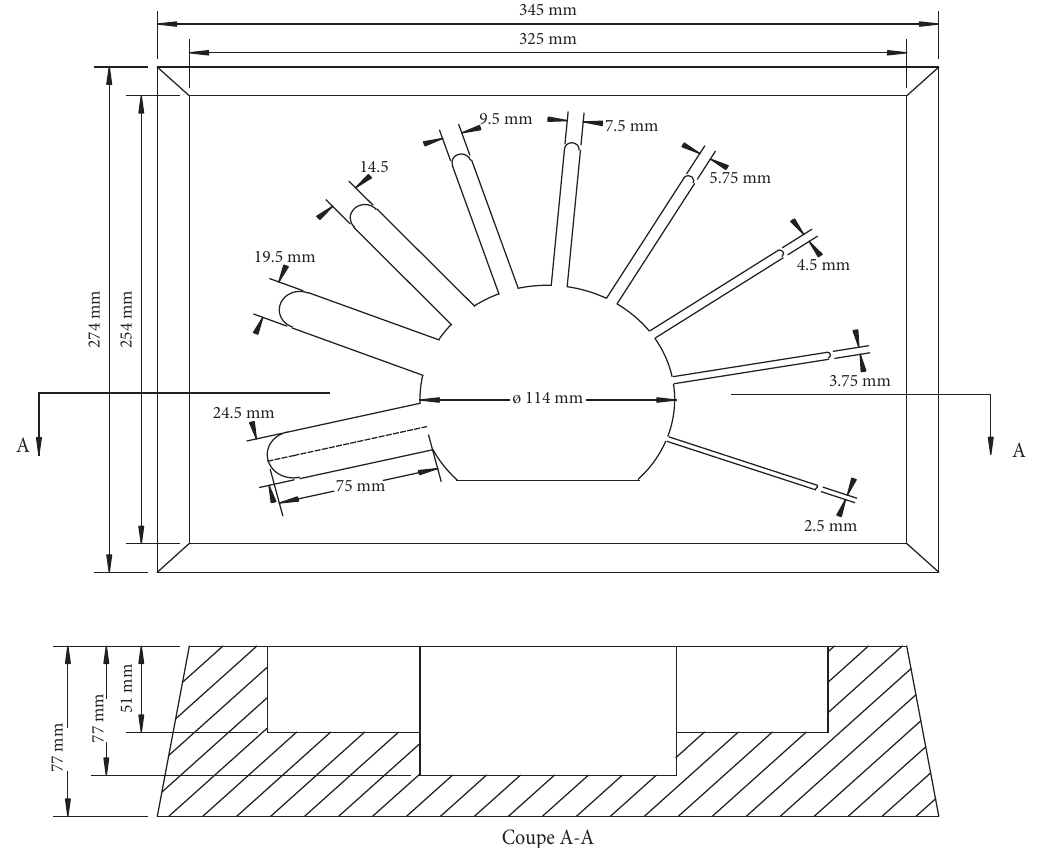
Figure 2: Schematic diagram of the sand mold